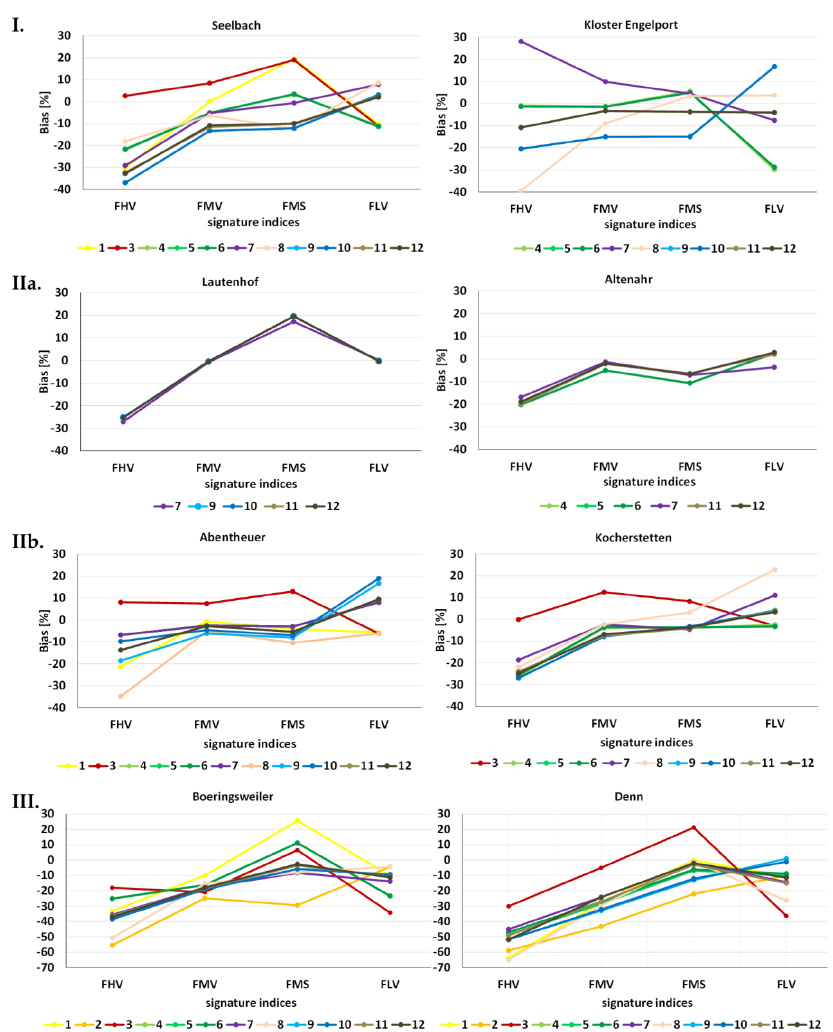
Figure 6. Different sensitivities of simulated runoff to model structures for single catchments. The signature indices of a catchment are displayed and connected by a line creating a performance pattern for this model. Model structures are indicated by colors and named in the legend with the number of the model structure. ( I ) displays examples of catchments with differentiated patterns of signature indices; ( II ) performance pattern of catchments with all ( a ) or most ( b ) acceptable models with similar patterns of signature indices; and ( III ) catchments without an acceptable model. ( I , II ) show only acceptable models for these catchments; ( III ) shows all models of a catchment.